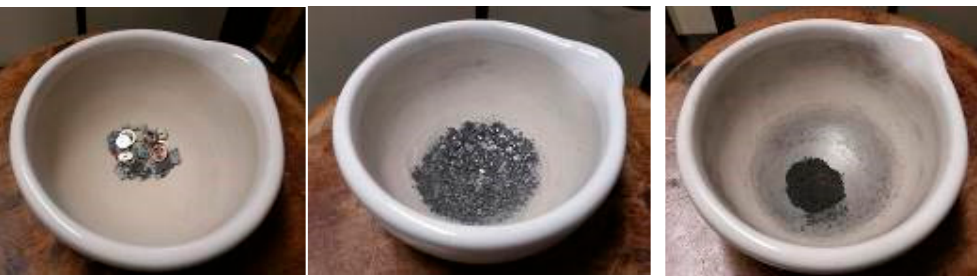
Figure 1. Grinding of NdFeB magnets from mobile phone devices with a mortar.